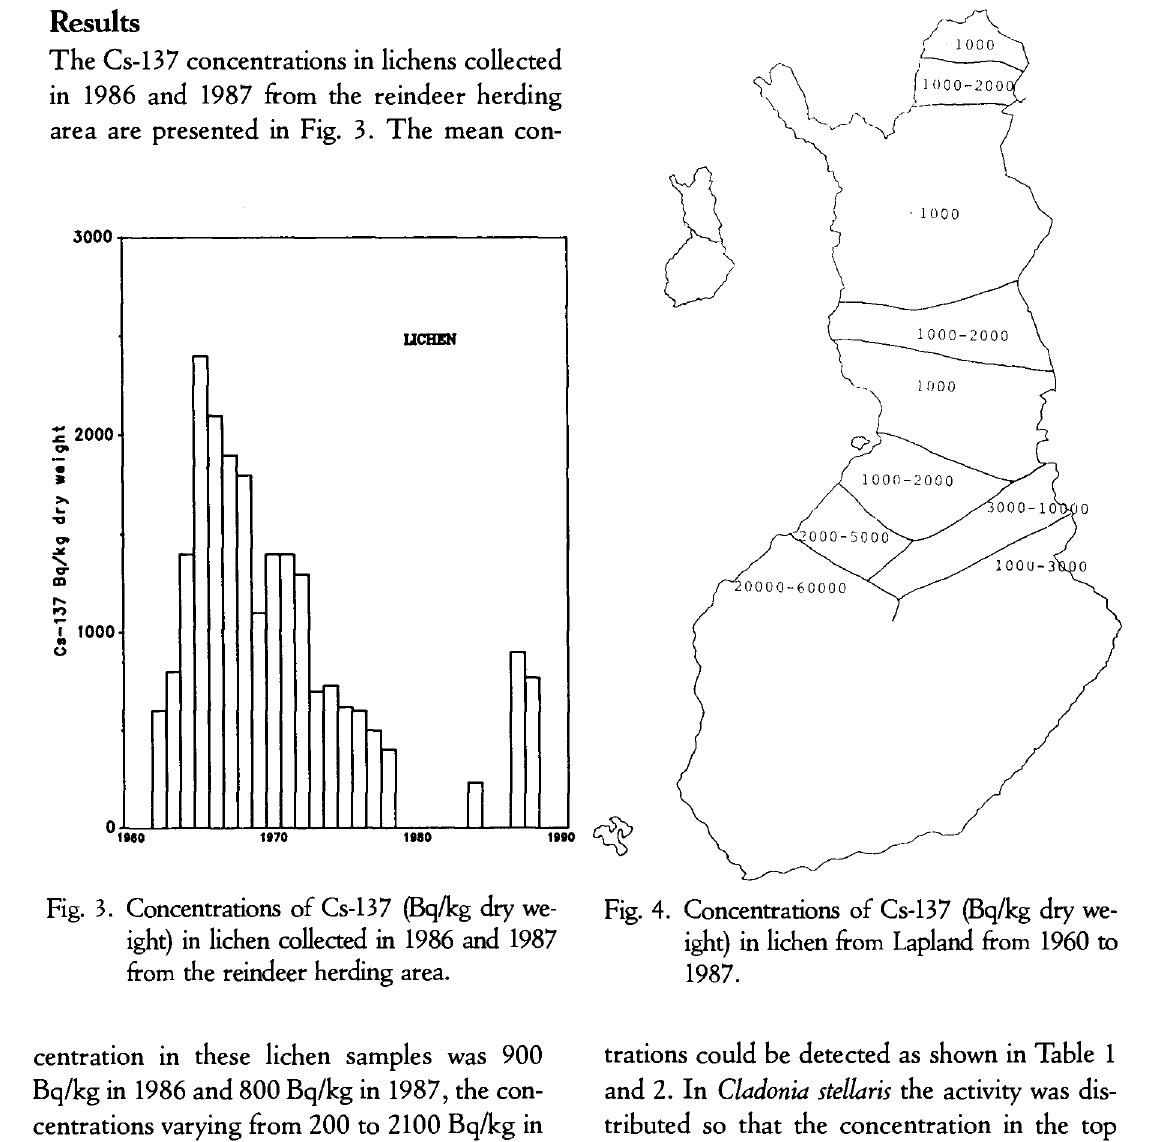
Fig. 4. Concentrations of Cs-137 (Bq/kg dry we ight) in lichen from Lapland from 1960 to